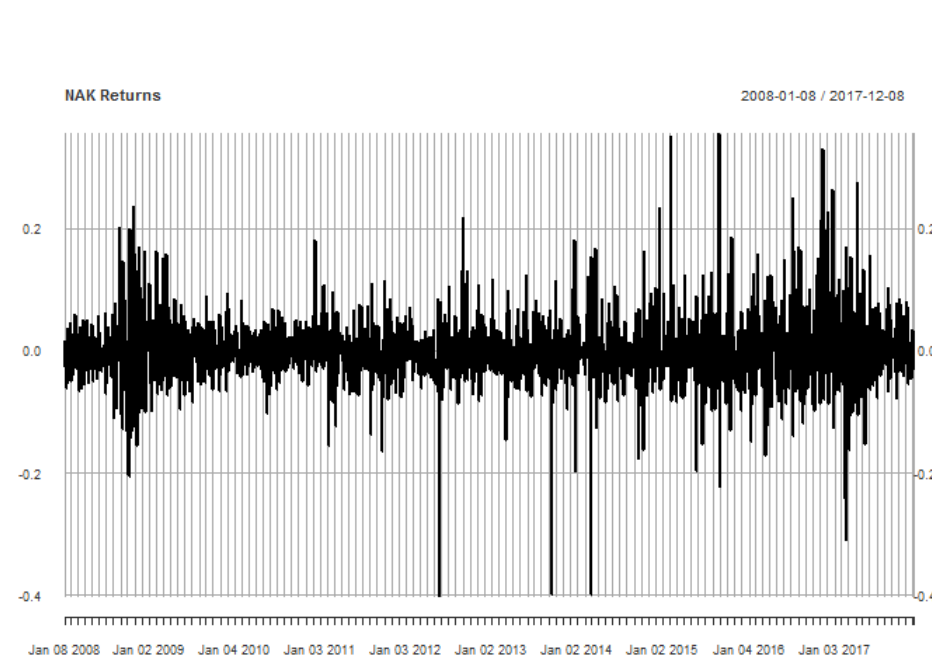
Figure 8. NAK Closing Prices (2008-2017)